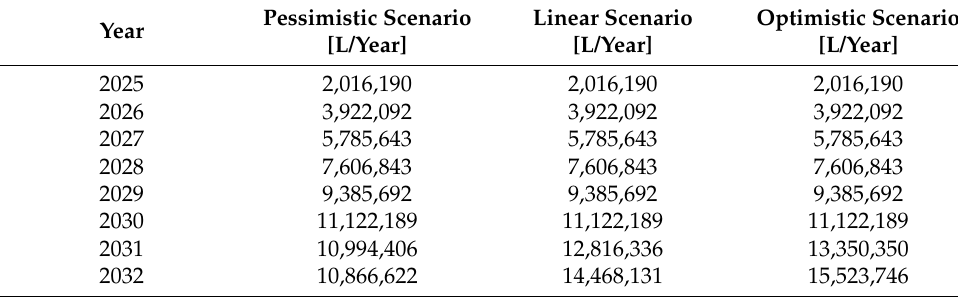
Table 9. Total fuel savings, w.r.t. no-FCEV